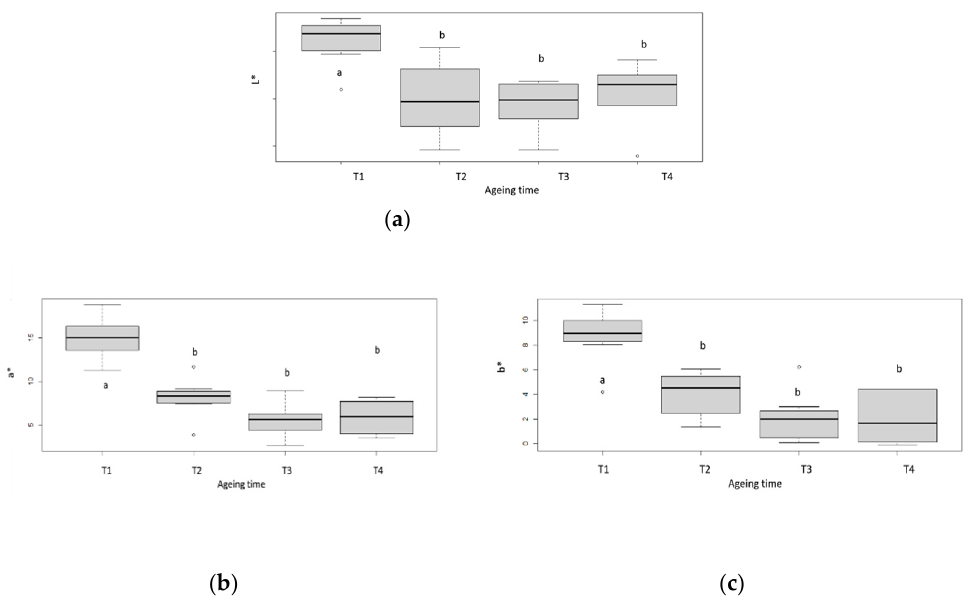
Figure 3. Box ‐ plot of trichromatic coordinates ( a ): L*; ( b ): a*; ( c ): b* of rib muscles. T1, T2, T3 and T4 correspond with the different ageing length (respectively 7, 16, 35 and 60 days).Box ‐ plot explanation: the central value represents the median; the edges of the rectangle are the quartiles and the extremities are calculated using 1.5 times the inter ‐ quartile range. a, b, c, d: significant differences ( p < 0,05)